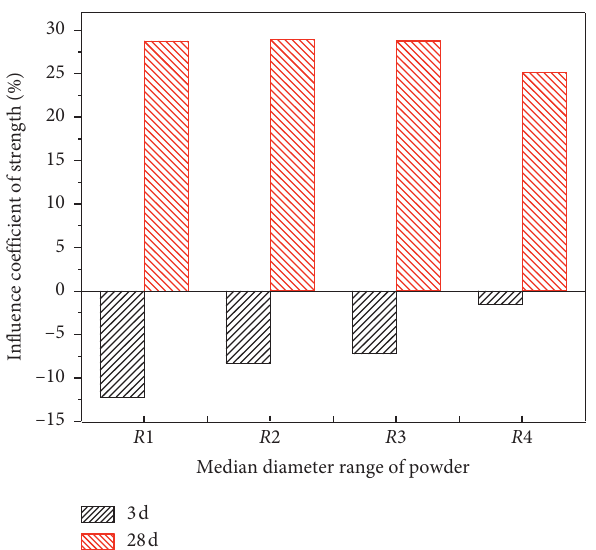
Figure 15: Strength contribution ratio of different particle size steel slag powder in blended